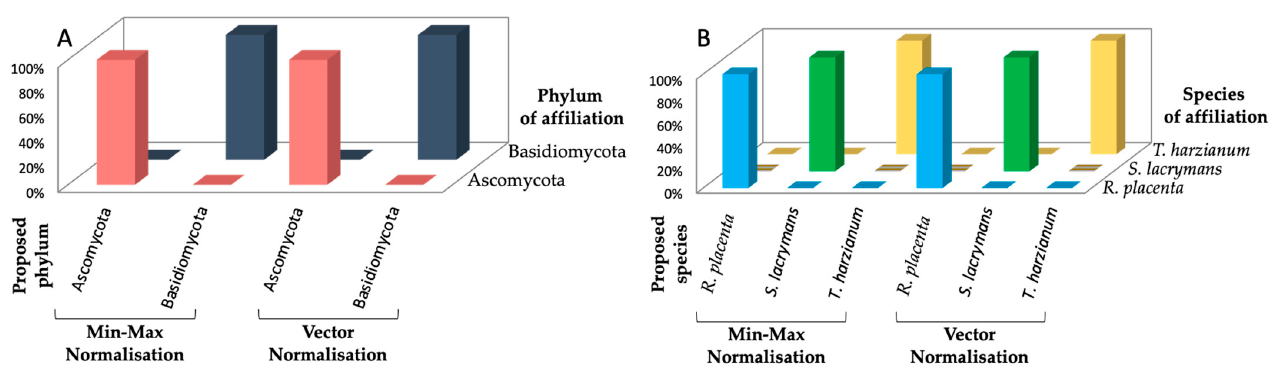
Figure 2. Confusion matrix obtained for the discrimination of the phylum (A) and the species (B) after growth on the polyether sulfone (PES) membrane and scraping the surface of the membrane to harvest the mycelium.